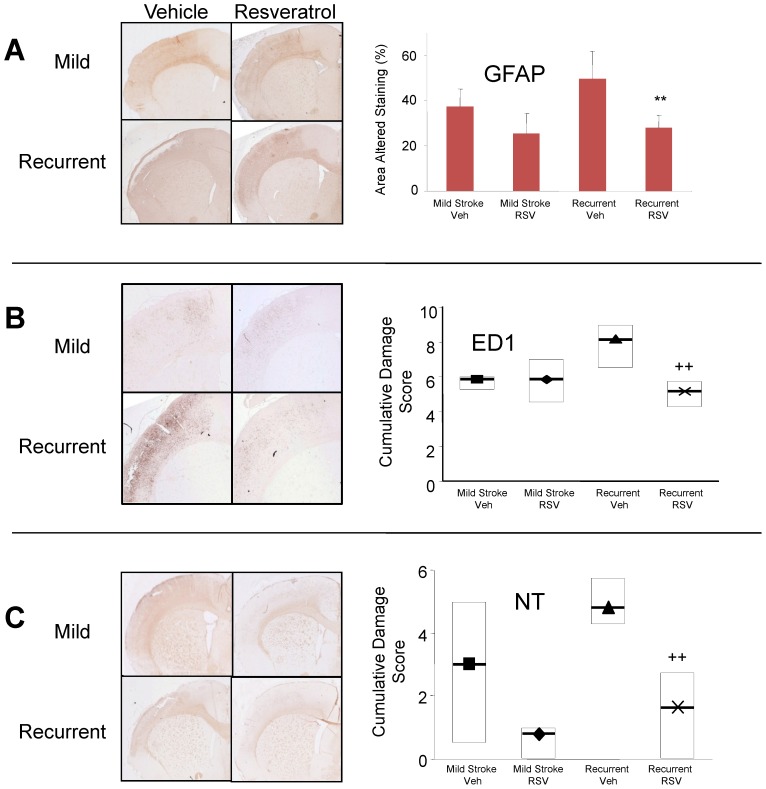
Representative brain sections depicting resveratrol (RSV) effects on glial activation, microglial/macrophage activation and nitrosative stress using respective immunostaining for: A - glial fibrillary acidic protein (GFAP), B – ED1 and C - nitrotyrosine (NT).Staining was assessed as the mean (±SD) area of altered GFAP stain presented as a percentage of the contralateral hemisphere or according to a median cumulative damage score (+/− first and third quartiles) of altered NT and ED1 staining. Significant RSV and vehicle (Veh) treatment differences were detected between respective stroke groups. ** P<0.005 (ANOVA and Student-Newman Keuls Test), ++ p<0.005 (ANOVA and Mann-Whitney Rank Sum Test).